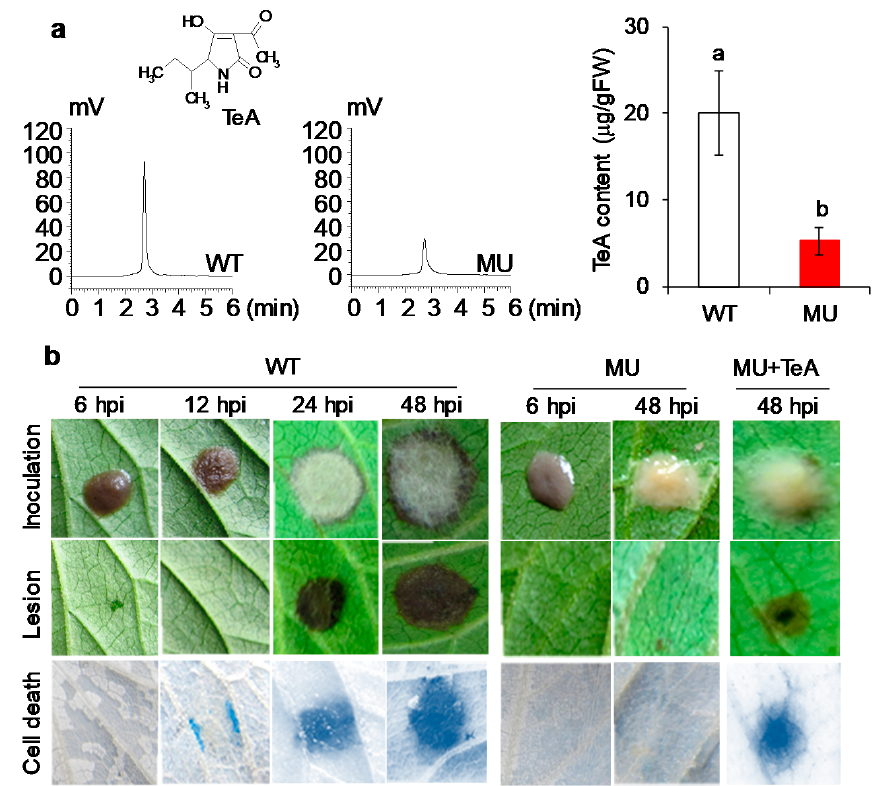
Figure 1. TeA is required for the virulence of A. alternata in A. adenophora . ( a ) TeA content of A. alternata wild-type strain (NEW001, WT) and mutant strain ( Δ HP001 , MU). The level of TeA of fresh deposited mycelia of A. alternata WT and MU were measured using HPLC. The results represent the means of three independent biological replicates. Data shown are mean values ± SD. Different small letters above the error bar indicate significance at 0.05 level. ( b ) Formation of cell death and leaf lesion in A. adenophora leaves induced by A. alternata WT, MU or MU with TeA. A 20 µ L of WT or MU mycelial homogenates or MU mycelial homogenates with 20 µ g mL − 1 TeA (10 µ L) (MU + TeA) were inoculated on the detached leaves of A. adenophora and incubated at 25 ◦ C for the indicated times. Then, photographs of A. alternata colony (inoculation), leaf lesion, and cell death were taken. Trypan blue staining revealed leaf cell death responses. Experiments were repeated at least three times with similar results.